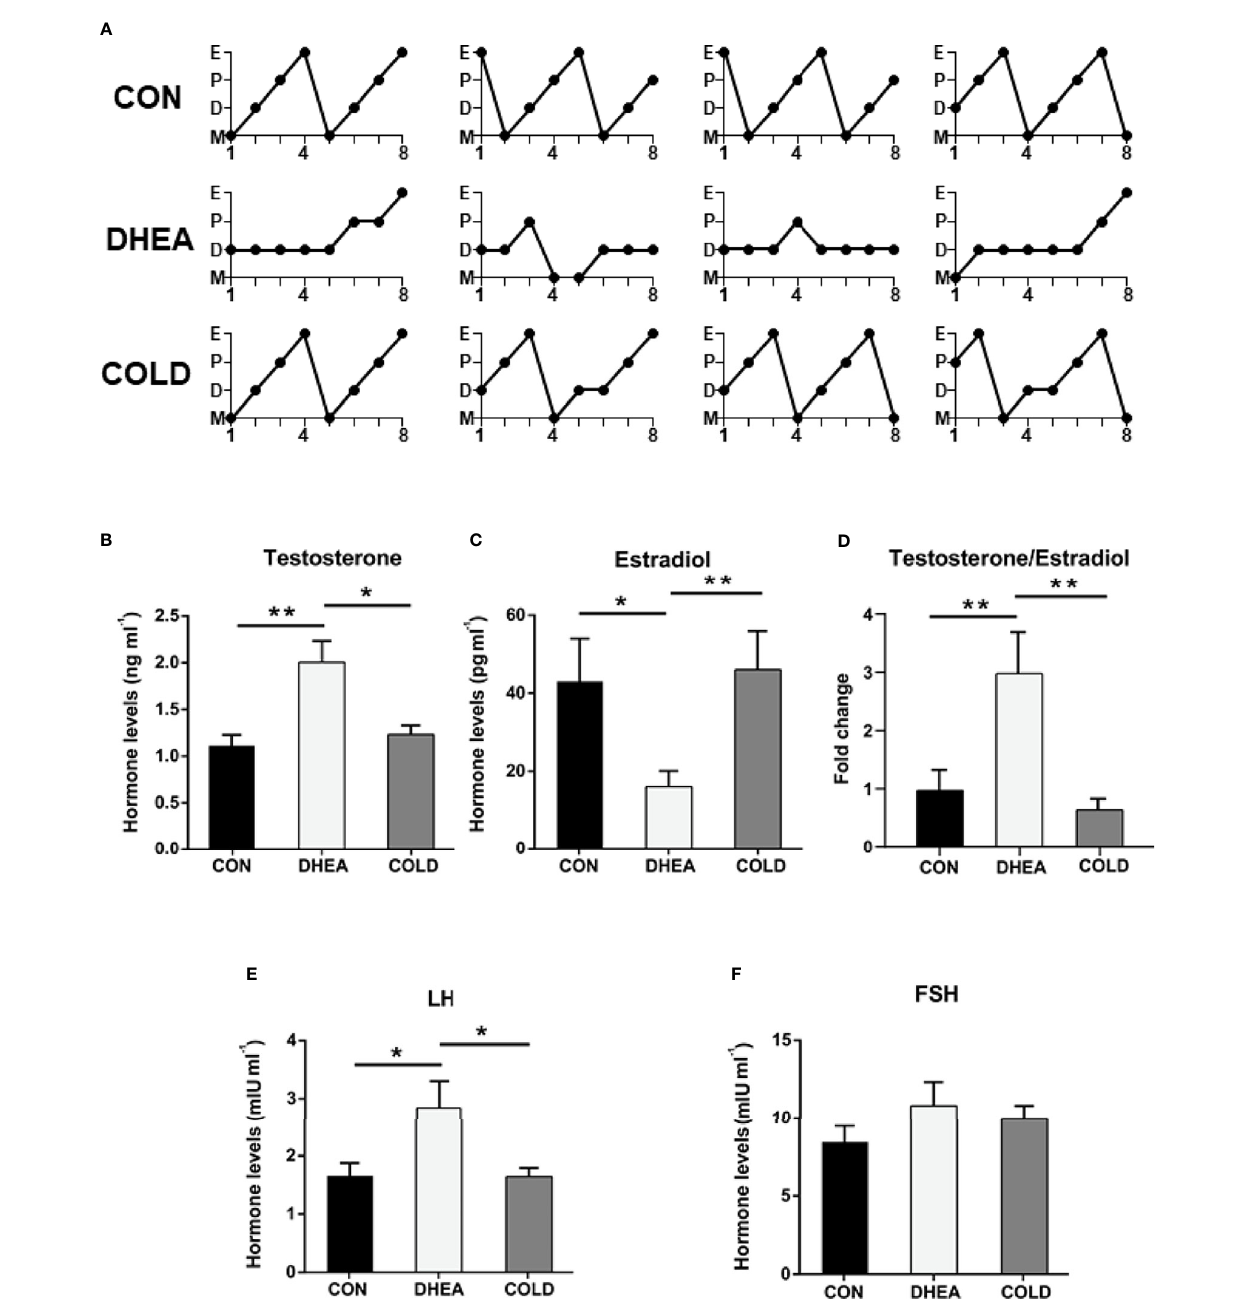
FIGURE 2 | Cold treatment ameliorated hyperandrogenism and ovarian acyclicity in PCOS rat. (A) Representative estrous cycles. The hormone levels of testosterone (B) , estradiol (C) , the normalized testosterone/estradiol ratio (D) , LH (E) and FSH (F) . Data are means ± SEM. (B – E) CON and COLD treatment (n = 8/ group), and DHEA treatment (n = 7/group). One-way ANOVA with Tukey post-hoc test was used to compare groups. * P < 0.05, ** P <